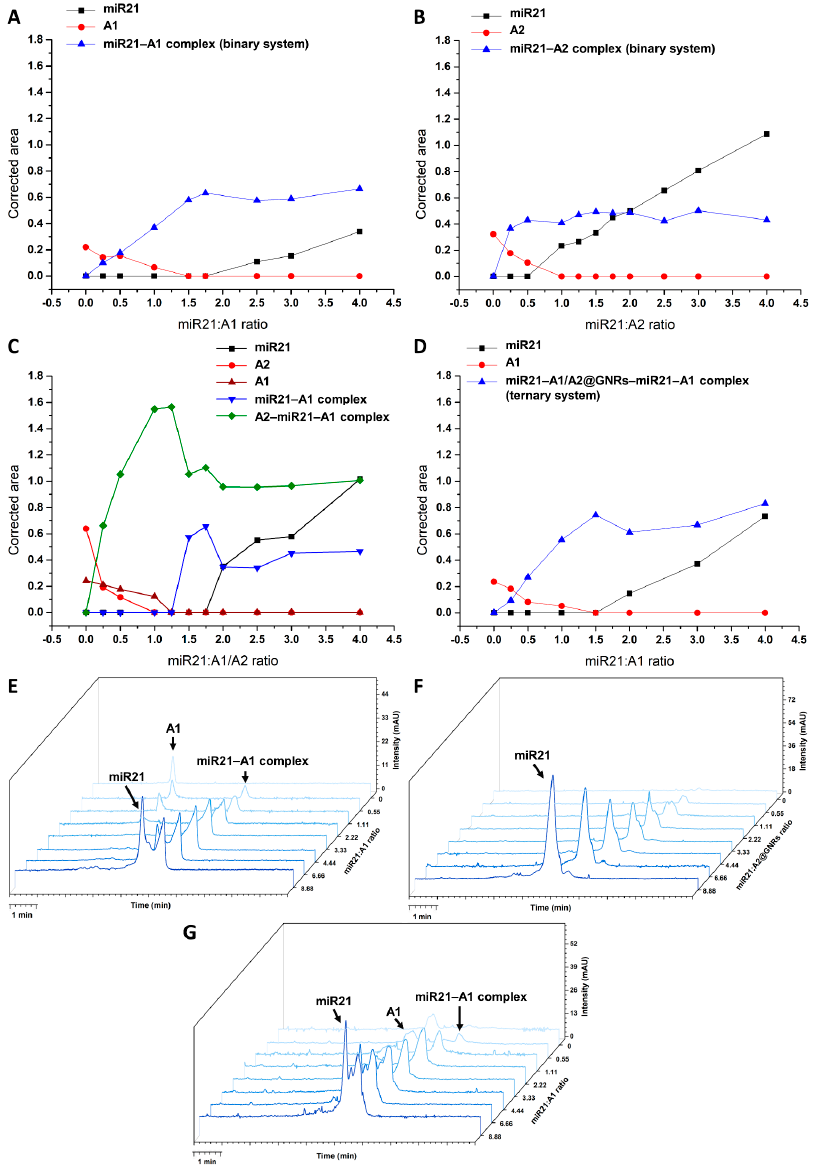
Figure 3. Binary system assessment between ( A ) miR21 (0–8.88 µ M)–A1 (2.22 µ M), ( B )